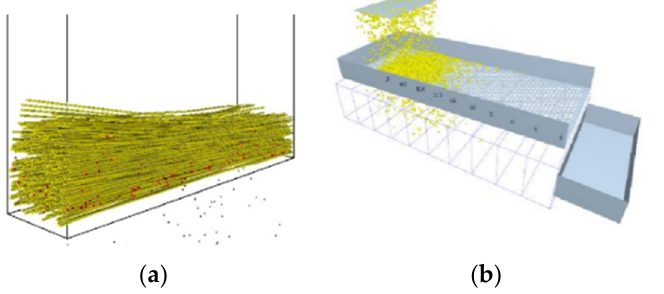
( d ) Figure 12. Simulation of a maize threshing process [100]. ( a ) Generation of corncob; ( b ) start of threshing; ( c ) during threshing; ( d ) end of threshing. 3.3.3. Simulation of Cleaning To study the separation of straw and grain in the screening process, Lenaerts et al. [107] analyzed the properties of straw and grains on screening speed (Figure 13a). Li et al.